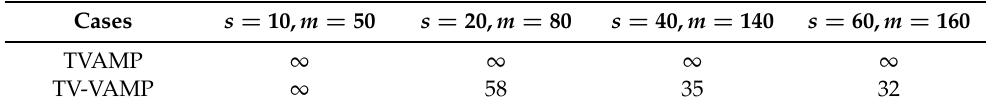
Figure 5. Normalized mean squared error (NMSE) convergence over iterations in the case of µ = 1 and n = 200. Each curve is the average of 50 Monte Carlo samples. Table 2. Average number of iterations to achieve NMSE = − 60 dB for non-zero-mean Gaussian distribution measurements